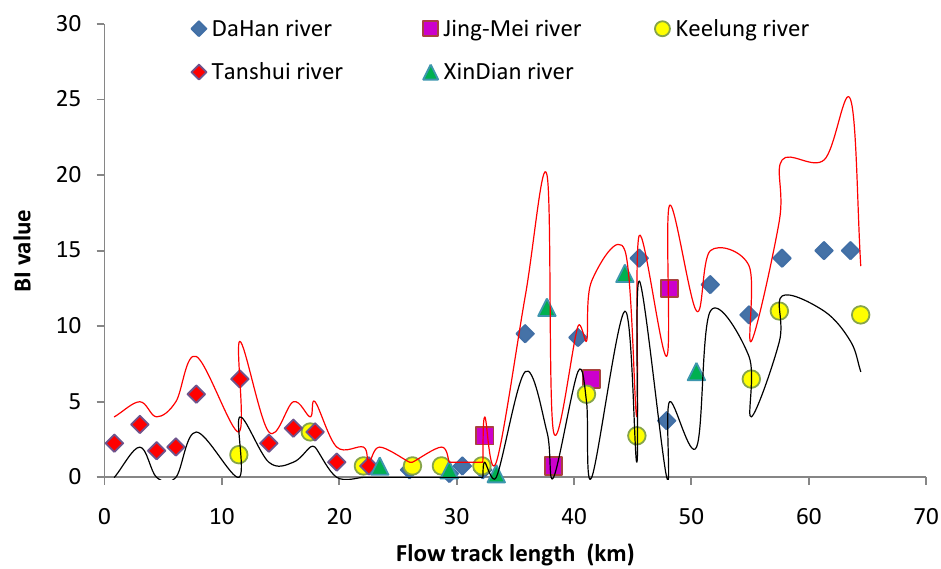
Figure 7. The BI value for the benthic macroinvertebrate community of the Tanshui River basin in 2012. The point marks indicate the mean of four seasons, red line was upper limit and black line was lower